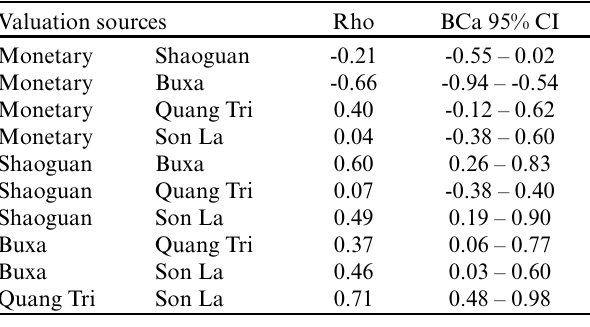
Table 1 . Spearman’s rho correlations and BCa 95% confidence intervals between valuation scores of freshwater ecosystem services by monetary assessment and stakeholder values at four sites in